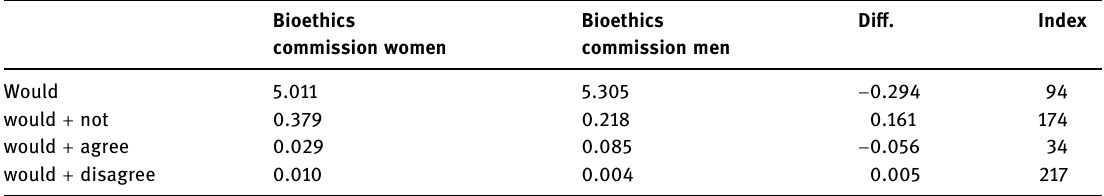
Table 12: Frequency of collocation of “ would ” with agreement and negation, as per cent of total tokens ( normalised, n = 1,000